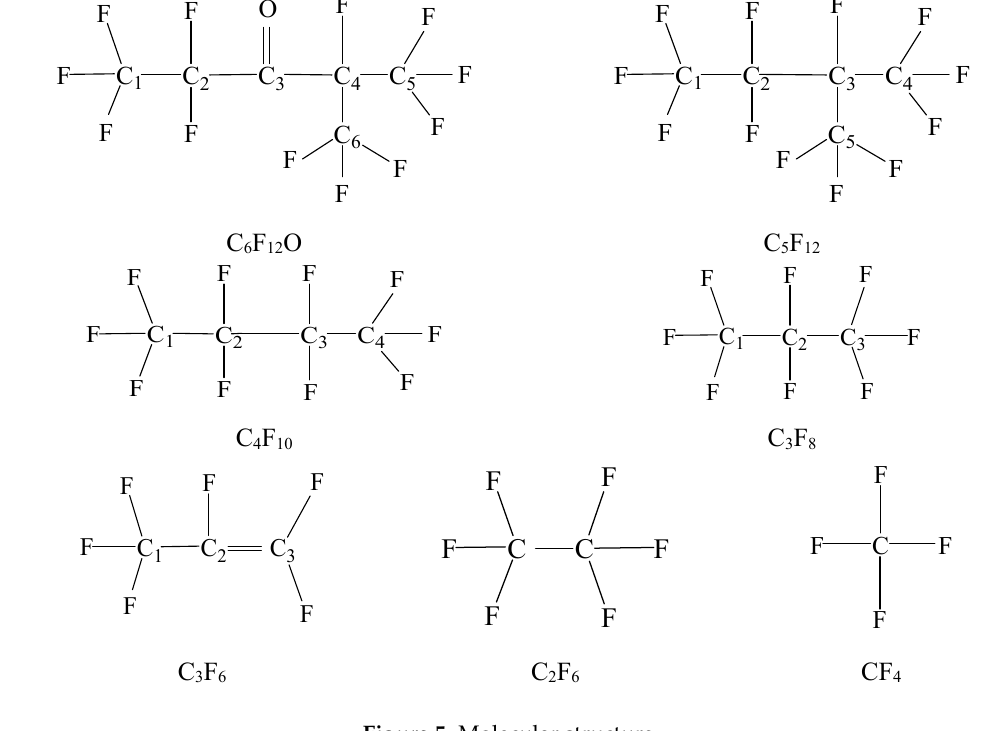
Figure 5. Molecular structure. Table 1 . Bond lengths and angles.